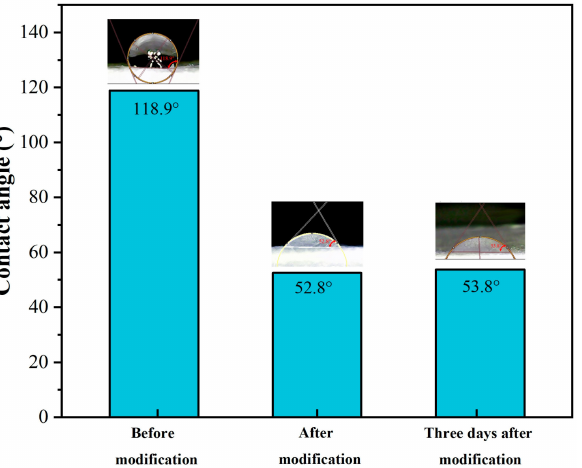
Figure 7. The surface contact angle of fiber samples before and after hydrophilic